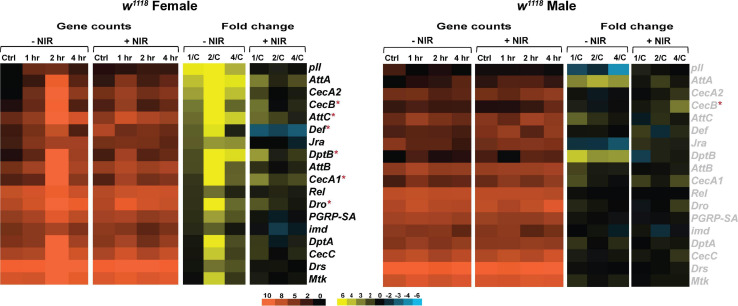
Immune response gene expression is downregulated in injured w1118 flies with post-NIR exposure. Heatmaps depicting immune response gene expression changes in w1118 females and males at control, 1, 2, and 4 hr after injury and NIR exposure. The orange scale represents average normalized counts for three replicates in each of the indicated groups. Yellow-blue scale shows fold change for each gene at 1-, 2-, and 4-hr post-injury compared to control. The genes indicated in black font are significantly changed in injured flies not exposed to NIR whereas red asterisk (*) indicates significant alteration in injured flies exposed to NIR (| log2FC| > 1, p-value < 0.05). 1/C: Fold change at 1 hr compared to control; 2/C: Fold change at 2 hr compared to control and 4/C: Fold change at 4 hr compared to control. (–NIR: not exposed to NIR and +NIR: exposed to NIR).